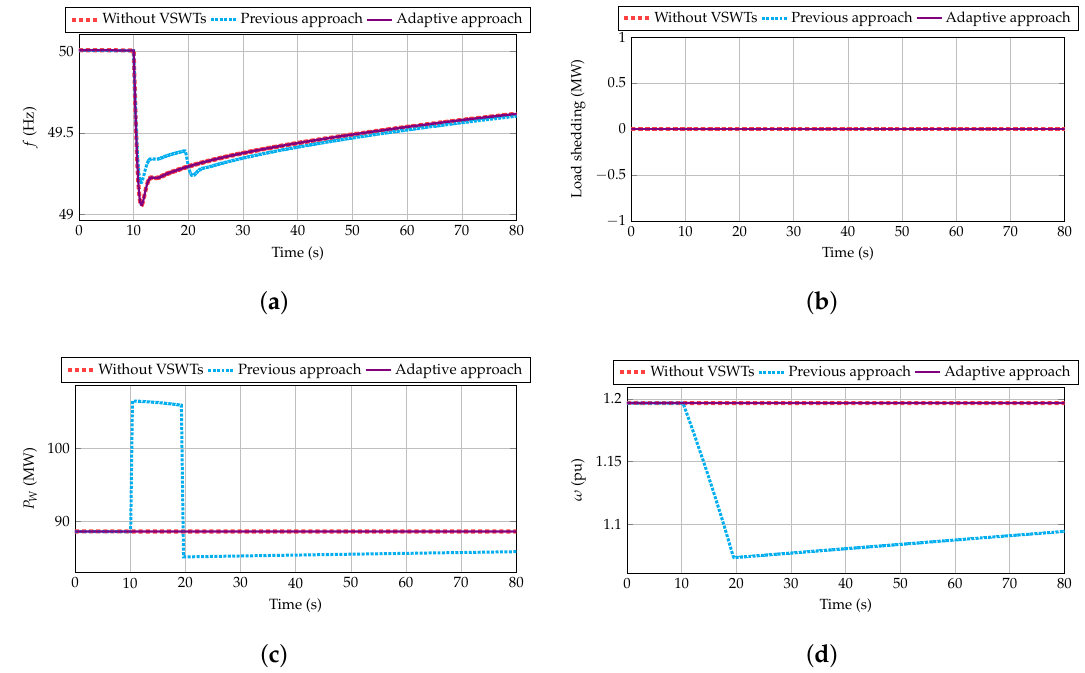
Figure 14. Results for scenario 27 ( a ) Frequency (Hz); ( b ) Load shedding (MW); ( c ) Wind power (MW); ( d ) VSWTs rotational speed